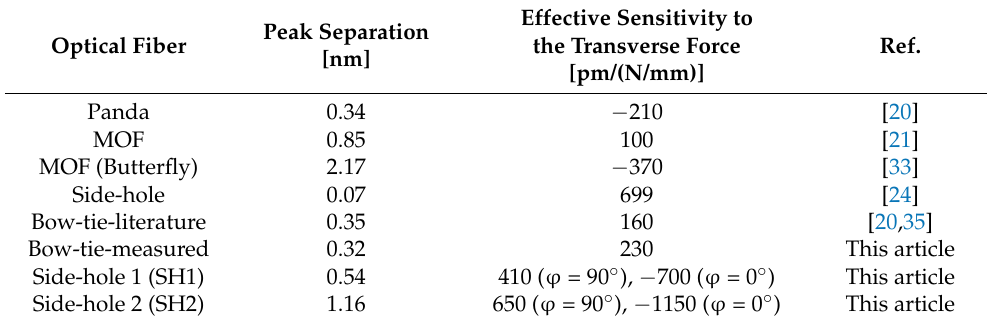
Table 2. Peak separation and maximum effective sensitivity for the transversal force for FBG sensors inscribed in different birefringent